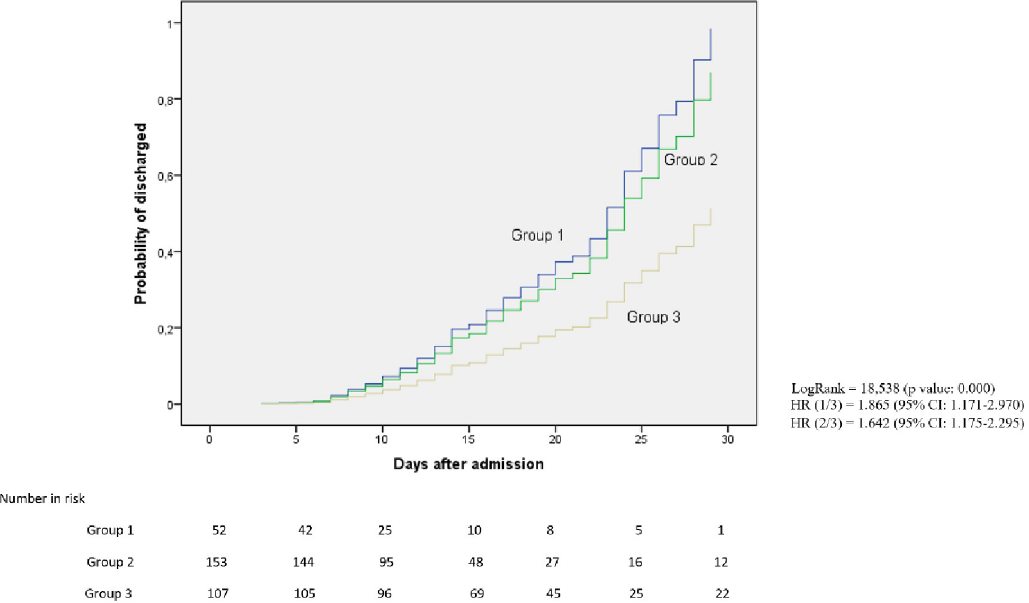
Fig 3. Probability of medical discharge at 30 days in the different treatment